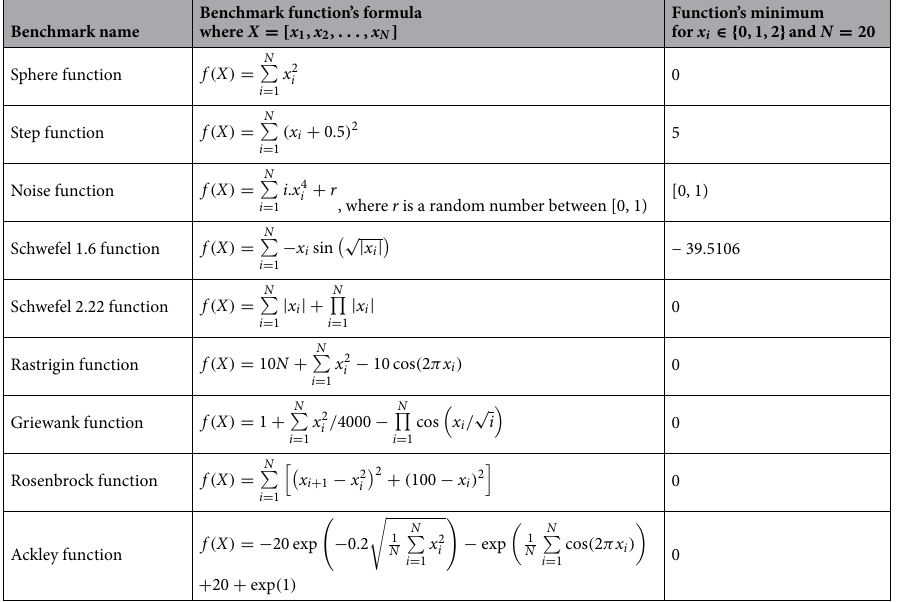
Table 1. Standard benchmark functions and their minimum values.